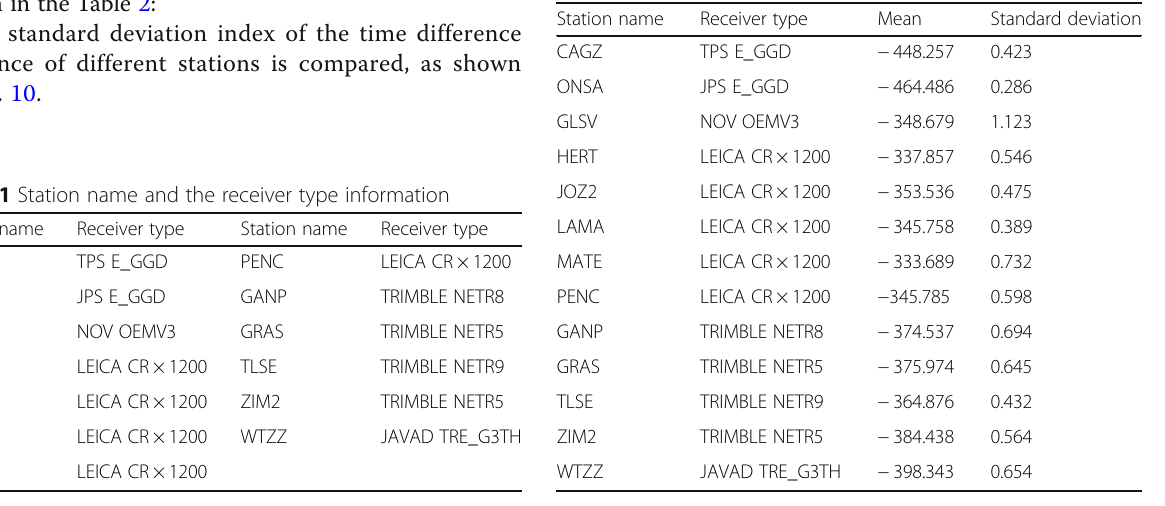
Table 2 Mean and standard deviation of the time difference sequence (unit: